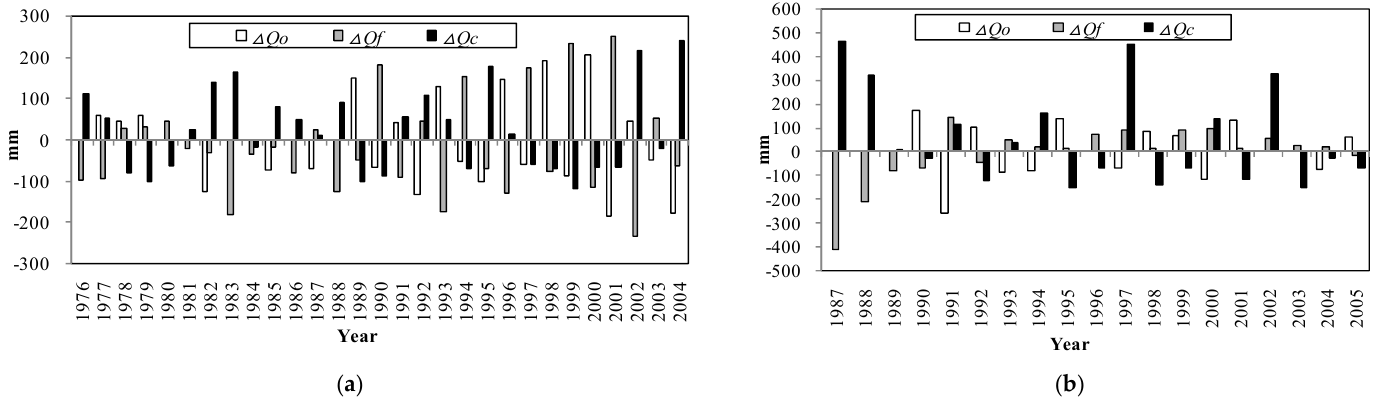
Figure 7. Dry season runoff variation attributed to climate variability ( ∆ Q c ), forest change ( ∆ Q f ) and other factors ( ∆ Q o ) in ( a ) the Zagunao watershed and ( b ) the Meijiang watershed. Table 7. Dry season runoff variations to climate variability, forest change and other factors in the study watersheds. Watershed